Question: Name the type of graph shown.
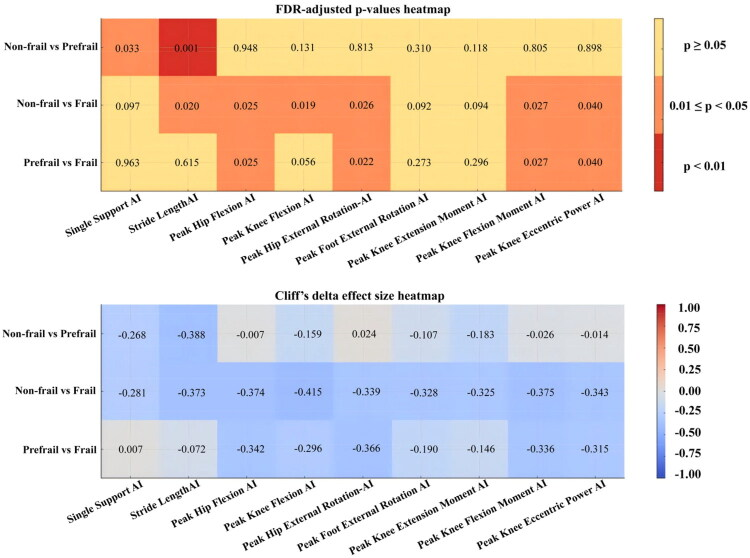
Answer: heatmap